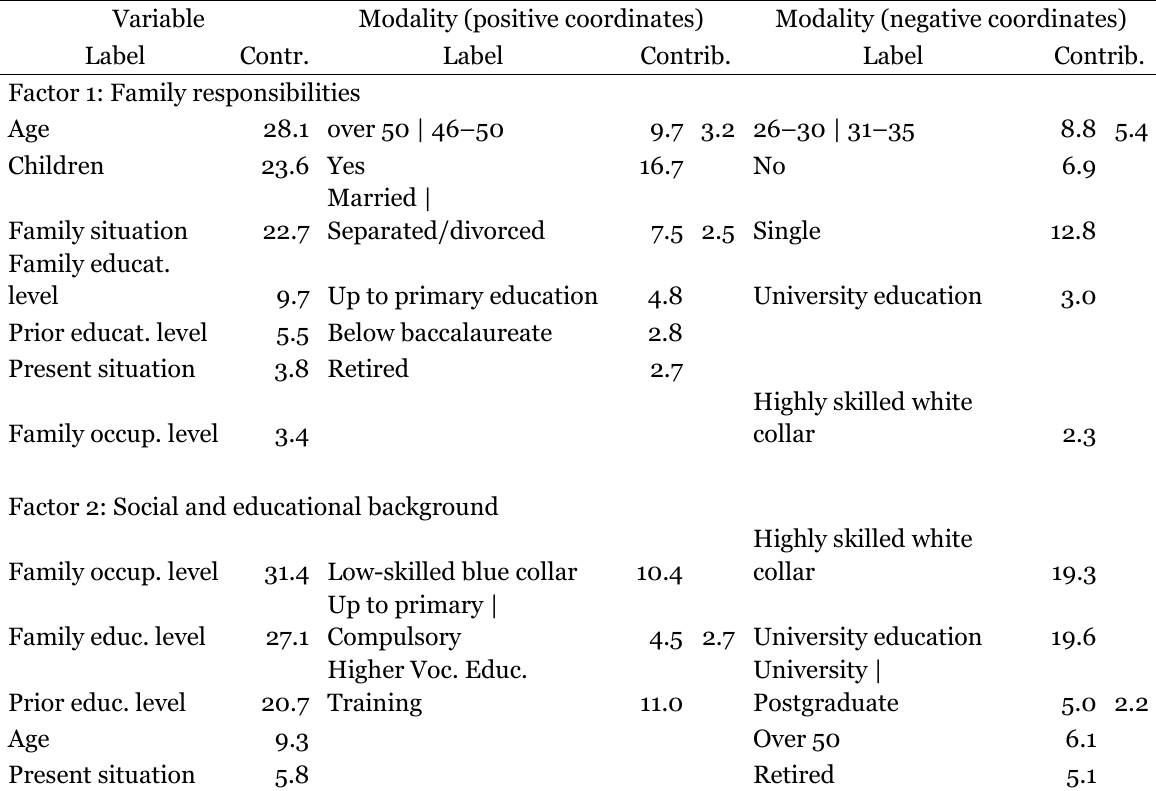
Contributions of Variables and Modalities to